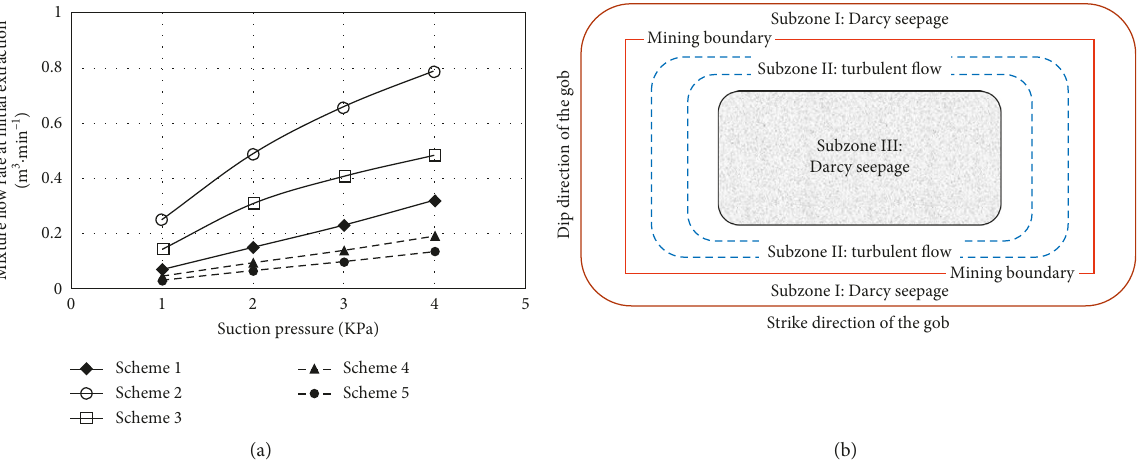
Figure 13: Distribution characteristics of the gas flow state in the gob under surface borehole extraction conditions: (a) mixture flow rate at initial extraction; (b) methane flow